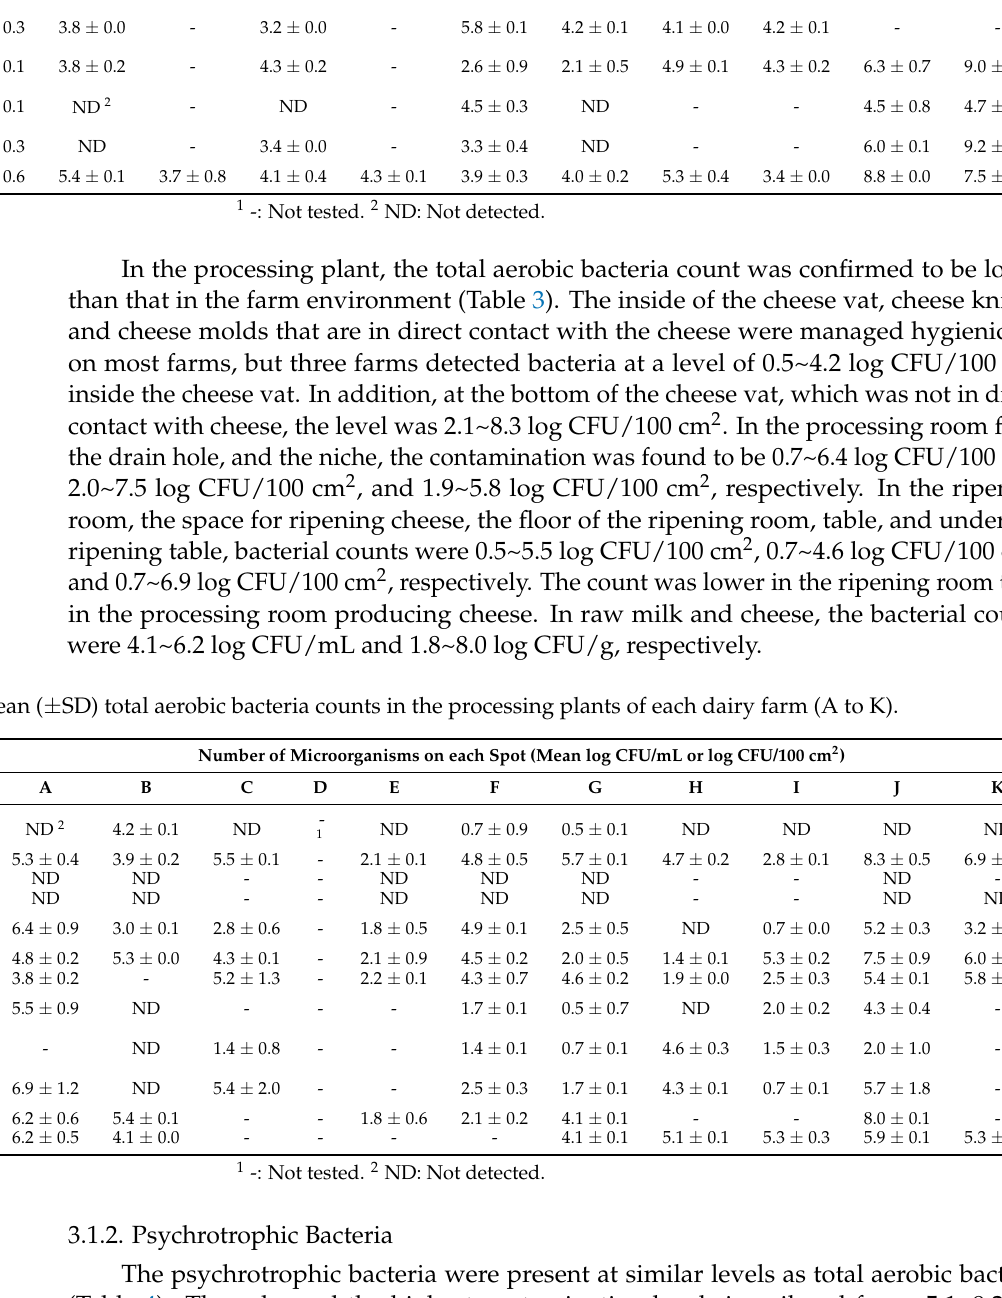
Table 2. Mean ( ± SD) total aerobic bacteria counts in the environment of each dairy farm (A to K). Sample